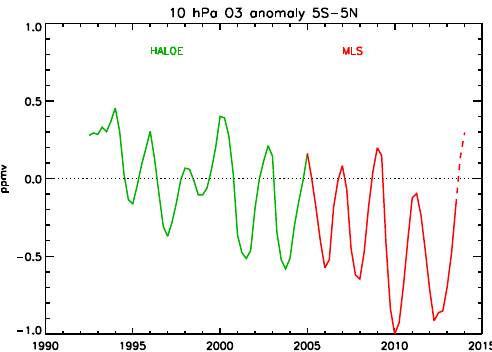
Figure 1. Annual median ozone anomalies at 10hPa 5 ◦ S–5 ◦ N from HALOE (green; HALOE data is actually shown on its native grid at 30km, which is ∼ 10hPa) and MLS (red). Annual anoma- lies are shown four times per year; hence each measurement is in- cluded in four data points. The MLS anomalies have been shifted by a constant mixing ratio so that the HALOE and MLS annual anoma- lies for 2005 (covering the period July 2004–June 2005) agree. The MLS data from July 2013 onwards is indicated dashed in order to indicate that this data will not be used in any of the linear trend calculations to be